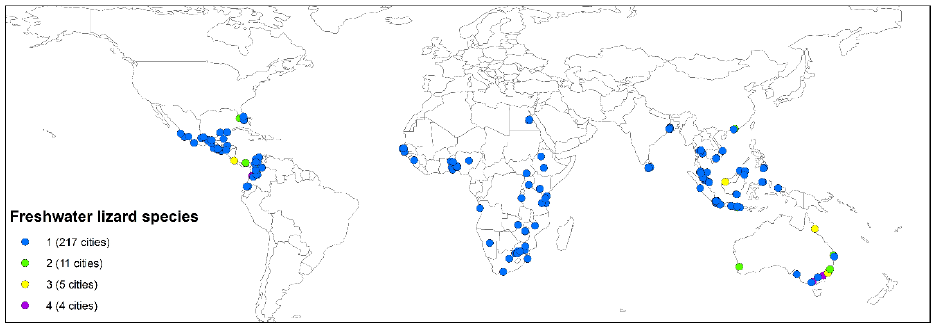
Figure 3. Number of freshwater turtle species sighted between January 2013 and April 2018 within 50 km of a city with a population of more than 100 000.